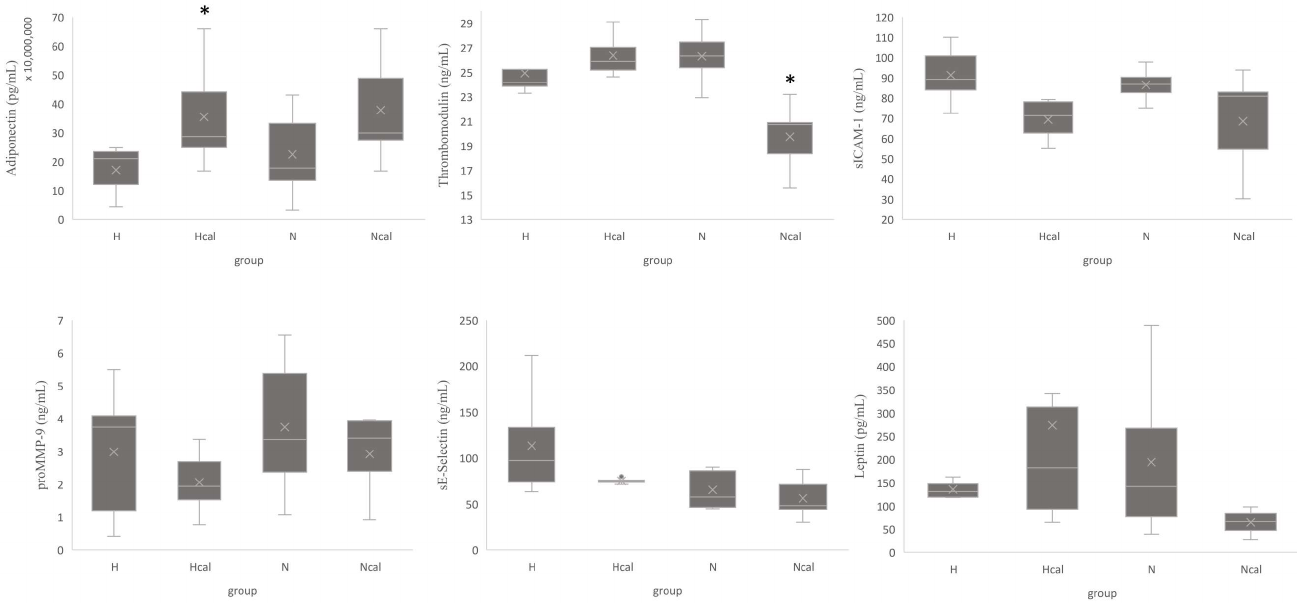
Figure 1. Box-plot proteins markers in endothelial dysfunction and adipokines related with metabolic risk factors. Data expressed as concentration in plasma samples (ng/mL or pg/mL) in different groups (mean X, median line and interquartile range in box-plot, * p < 0.05 H-Hcal N-Ncal). H—High- fat diet group; N—normal diet group; Hcal—High-fat diet group with calafate; Ncal—Normal diet with calafate. Finally, leptin is an adipokine produced by white adipose tissue, and its disruption marks a milestone in the development of metabolic diseases, such as obesity, type 2 dia- betes, and hypertension [38,39]. Agostinis-Sobrinho et al., 2017 showed a positive correla- tion between leptin and the leptin/adiponectin ratio and all metabolic risk factors (MRFs), such as triglycerides, HOMA-IR, and blood pressure. In addition, ROC-curve analyses showed that adiponectin, leptin, and the L/A ratio were predictive biomarkers of MRFs [40]. According to our results and based on these antecedents, regulation of these bi- omarkers produced by calafate-extract consumption can reduce the risk factors for CVD in mice. 3.4. Metabolomics Typical base peak chromatograms of the plasma extract obtained with the different chromatographic methods are illustrated in Figures S4 and S5. After applying the de- scribed workflow (Section 2.2.6), the bucket table presented 39,227, 5464 and 15,778 fea- tures for methods 1, 2 and 3, respectively, in negative mode and 11,028, 19,929 and 11,070 in positive mode. After QC feature filtration [41], a total of 32,181 and 7652 features were deleted for negative and positive methods 1, 4030 and 16,657 for method 2, and 11,012 and 7844 for method 3. This supports the quality of the metabolomics data. First, PCA examined spontaneous clustering patterns in the datasets, and as seen in Figures S6 and S7, the QCs were clustered in the center of the models. PCA models ob- tained with method 1 in negative ionization mode explained a total variance of 65.6% be- tween principal component PC 1 and PC 2. In method 2, these components explained 80%,